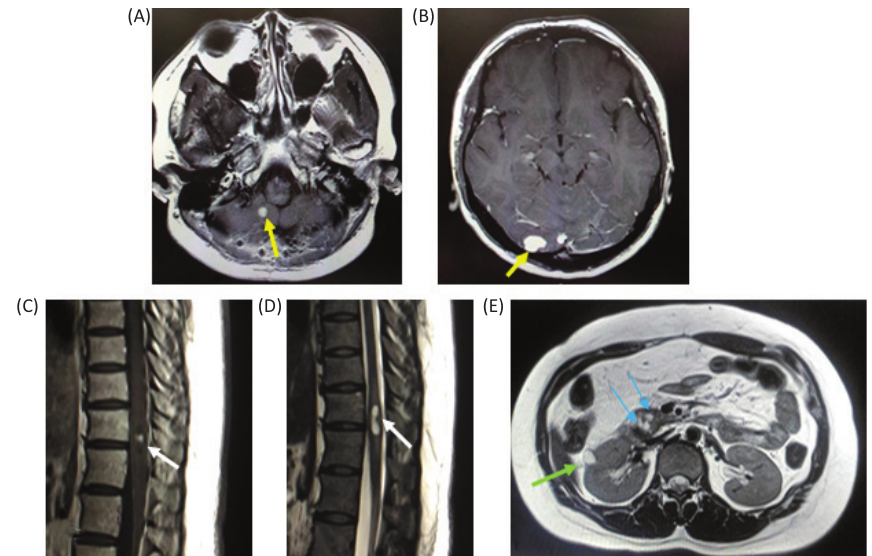
Figure 2. Magnetic resonance imaging of the patient. (A and B) Gadolinium (Gd)-enhanced T1-weighted image of cerebellum when the patient was 26 years old. The patient had multiple cerebellar hemangioblastomas. (C) Gd-enhanced T1-weighted image of the lower thoracic cord. A small hemangioblatoma with a syrinx is shown. (D) T2-weighted image of the lower thoracic cord.